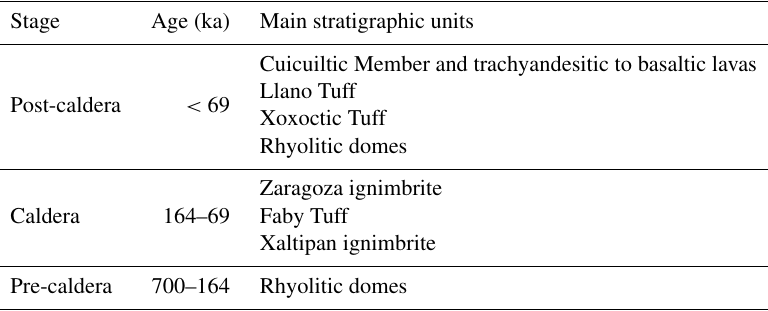
Table 1. Summary of the main stratigraphic units of the three evolutionary stages of the Los Humeros volcanic complex (Carrasco-Núñez et al., 2017a,